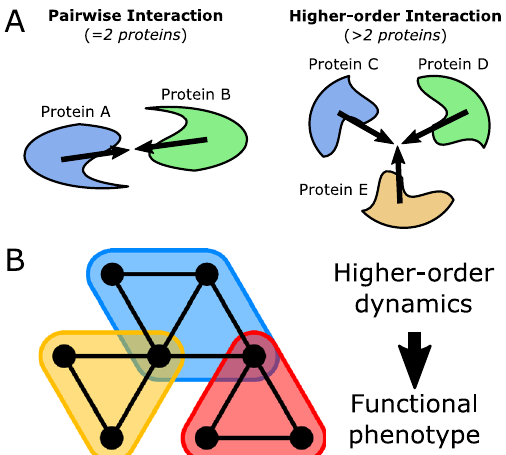
Figure 1. Hypergraph model of higher-order protein interactions. ( A ) Illustration of two types of protein interactions: pairwise interaction between 2 proteins, and higher-order interaction between > 2 proteins. ( B ) Hypergraph model of higher-order interactions (shaded bubbles) among multiple proteins (black